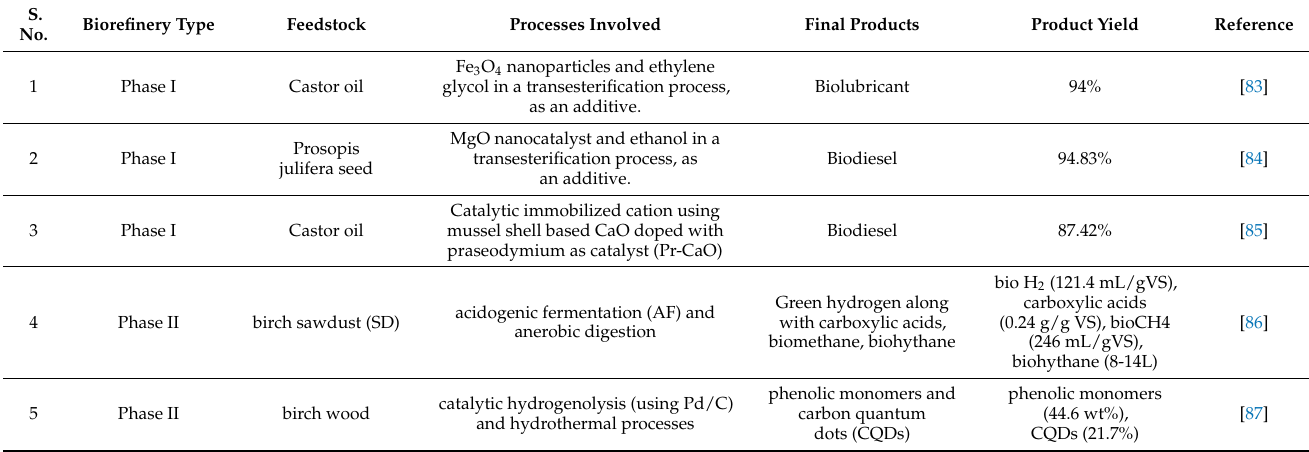
Table 3. Lignocellulosic biomass biorefinery (Phase I, II and